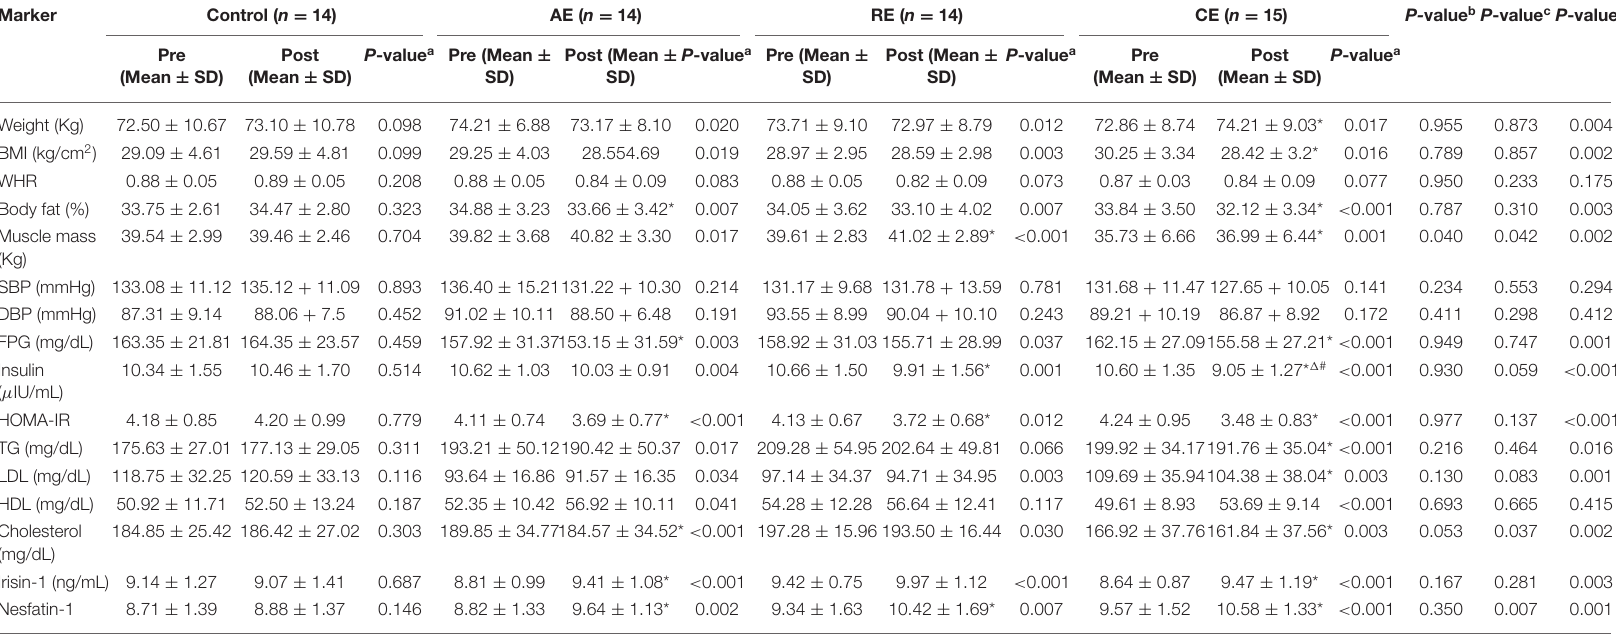
a Paired sample t-test, b One-way ANOVA between pre-test measurements, c One-way ANOVA between post-test measurements, d Analysis of covariance of post-test measurements with pre-test measurements as covariates. BMI, Body Mass Index; WHR, Waist to Hip Ratio; SBP, systolic Blood Pressure; DBP, Diastolic Blood Pressure; FPG, Fasting Plasma Glucose; HOMIIR, Homeostatic Model Assessment for Insulin Resistance; HDL, High-Density Lipoprotein; LDL, Low-Density Lipoprotein; TG, Triglyceride. * Significant difference vs. control